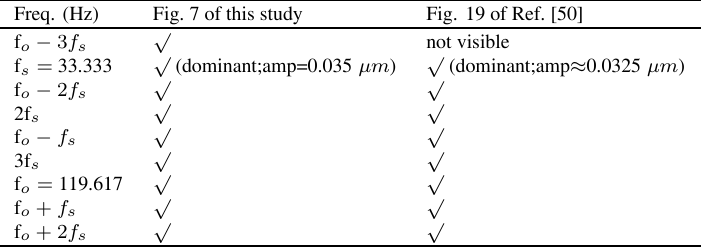
Table 5 Rotor vertical displacement spectra of this study and Ref.